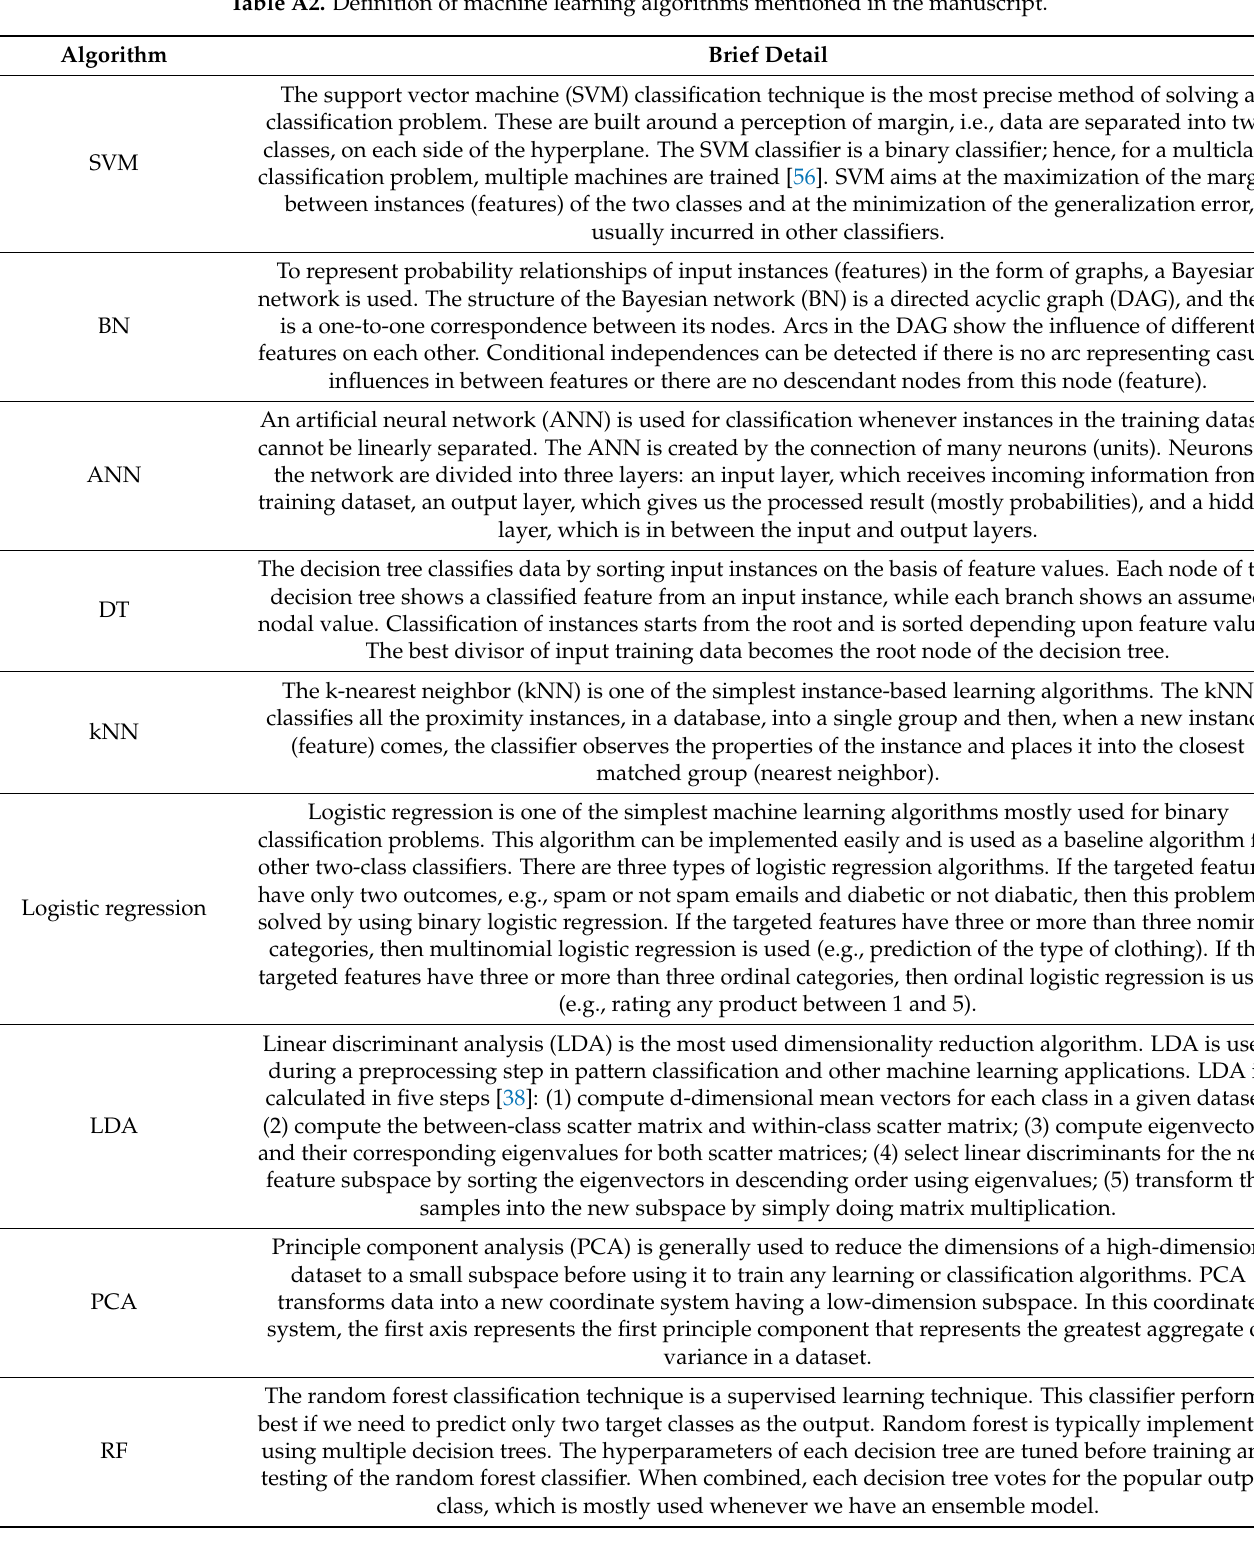
Table A2. Definition of machine learning algorithms mentioned in the